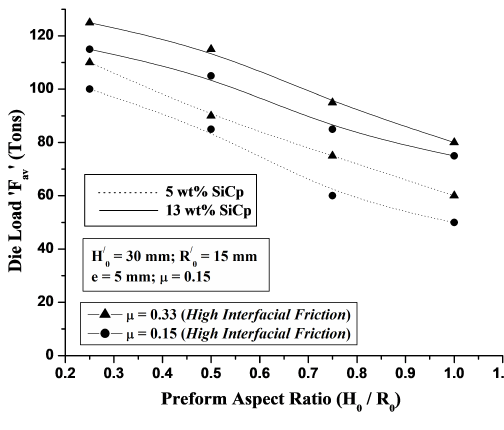
Fig. 10. Variation of Die Load with Preform Aspect Ratio.